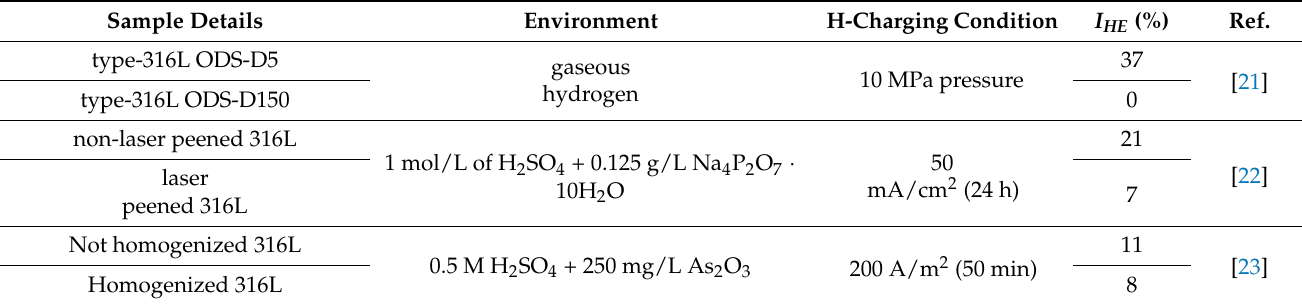
Figure 2. ( a ) Engineering tensile stress and strain curve of uncharged and H-charged samples; ( b ) the strain-hardening curves of uncharged and H-charged samples; ( c ) Tensile properties of uncharged and H-charged samples; ( d ) Comparison of HE susceptibility between this work and the reported studies for various 316L SS. Table 3. Various conditions studies on HE resistance of 316L stainless